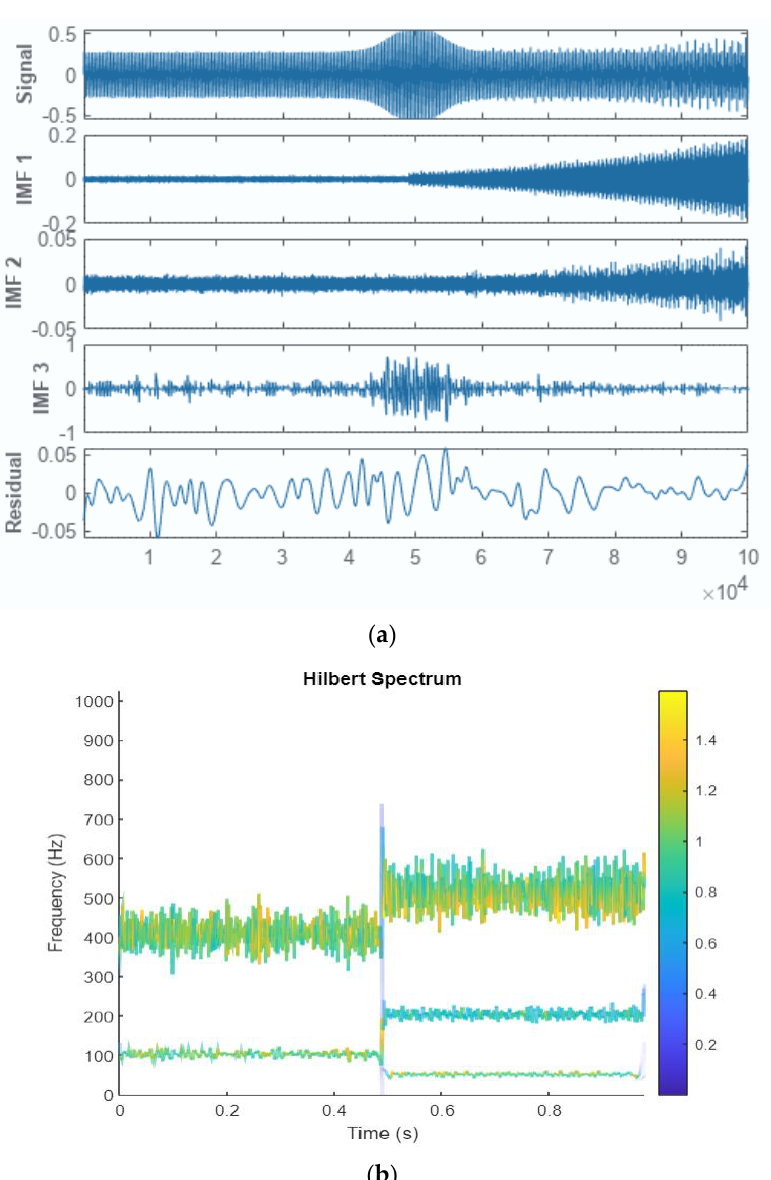
Figure 8. ( a ) Ensemble Empirical mode decomposition (EEMD) of HIF signal ( b ) Hilbert transform of IMF 3.